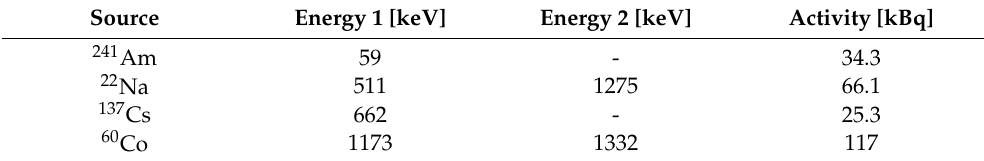
Table 1. The used laboratory sources, their activities and their full-energy peak gamma energies.